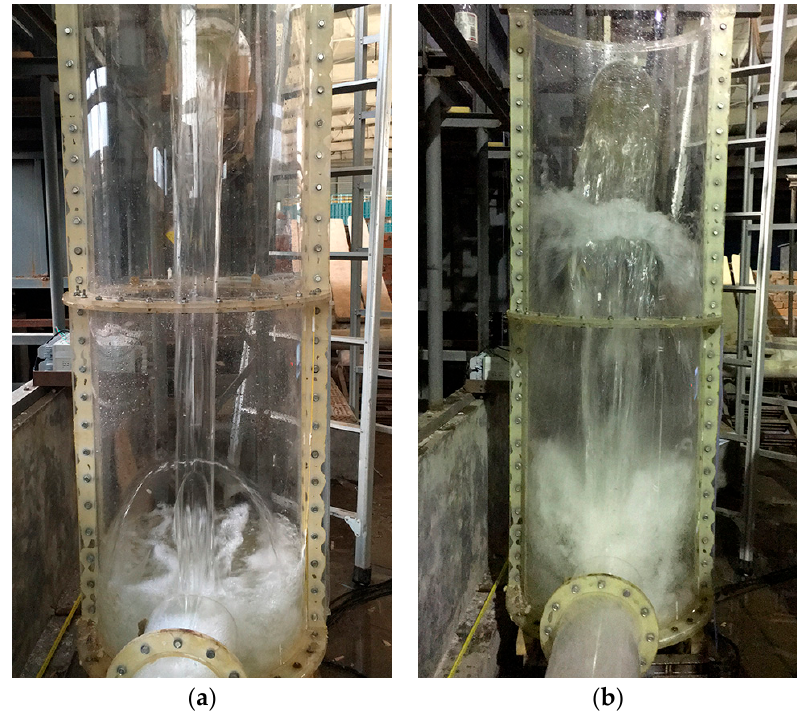
Figure 3. Regime R3 for s = 1.5 m with Regimes ( a ) R3a; and ( b ) R3b. Table 2. Shape of free flow jet before impingement.